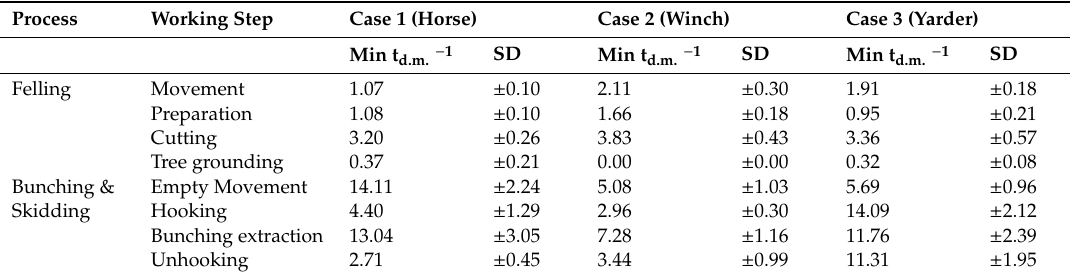
Figure 3. Resulting working productivity for the processes felling and bunching and skidding, per case and in t d.m. PMH 15 − 1 . Note: productivity results were shown in t d.m. PMH 15 − 1 ; and not in the Table 4. Resulting average distribution of net working time per working step of the processes felling and bunching and